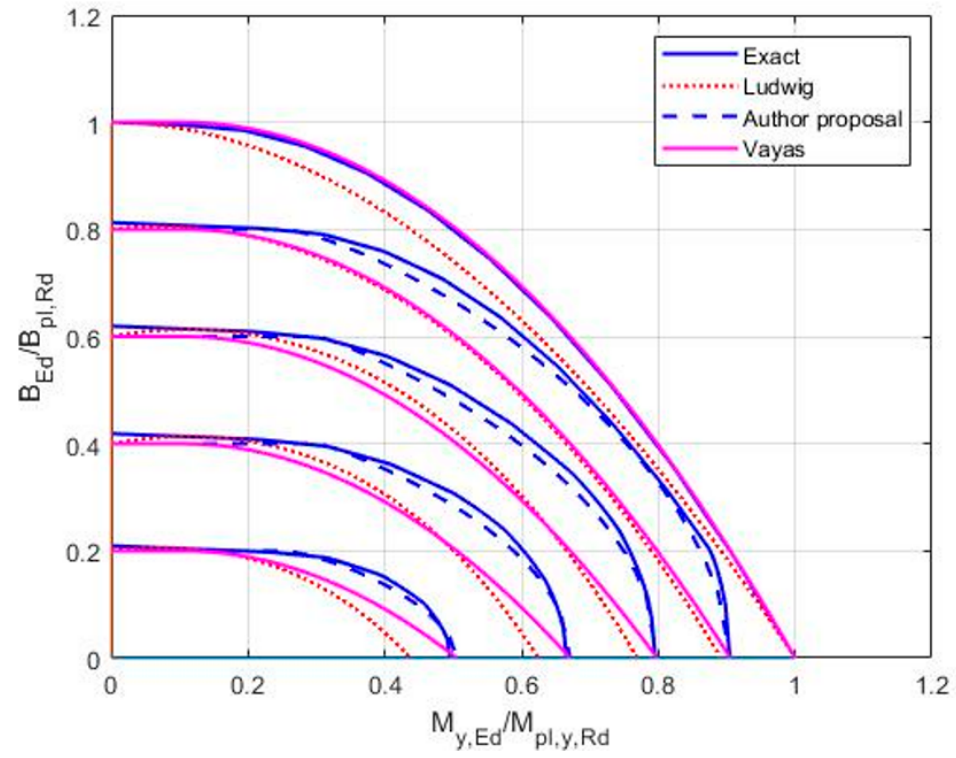
Figure 2. HEB 200. Comparison of the exact curves obtained by linear programming with: (i) the results of authors (Table 1 below, Equation (37)); (ii) the results of Vayas [6]; (iii) and the results of Ludwig [7]. The parameters of the curves from top to bottom are M z,Ed / M pl . z . Rd = 0; 0.2; 0.4; 0.6; 0.8.